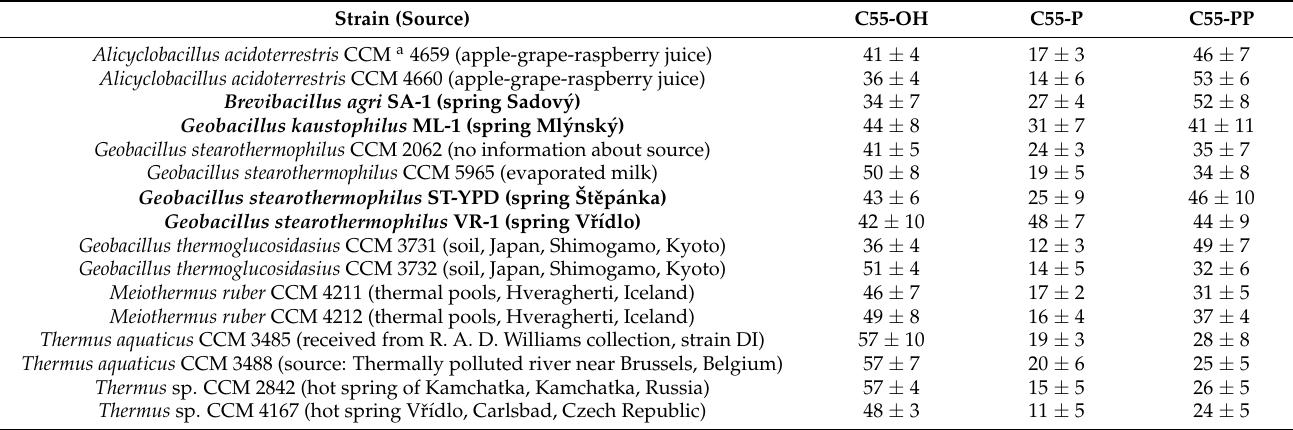
Table 3. Content (relative %) of polyprenol derivatives from 16 strains of thermophilic bacteria obtained after saponification using reverse-phase liquid chromatography-positive electrospray mass spectrometry, see Materials and Methods. Strain (Source) C55-OH C55-P C55-PP